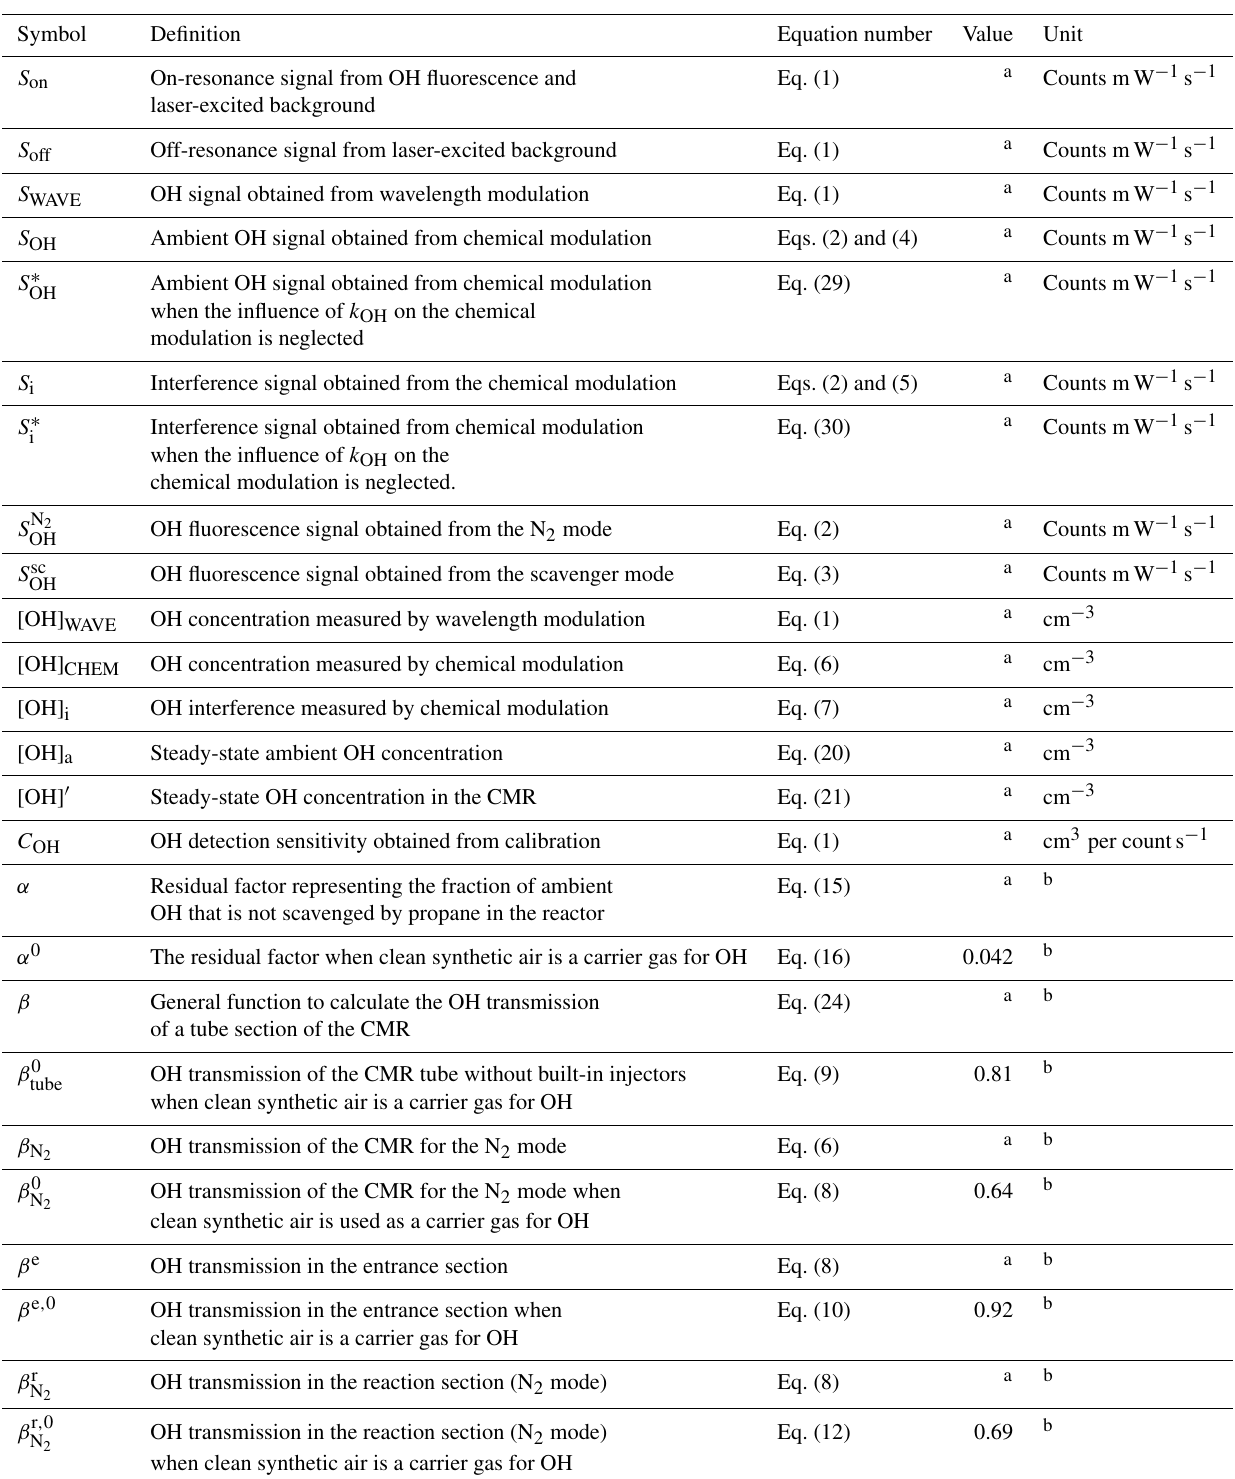
Table A1. Specification of CMR parameters used in this